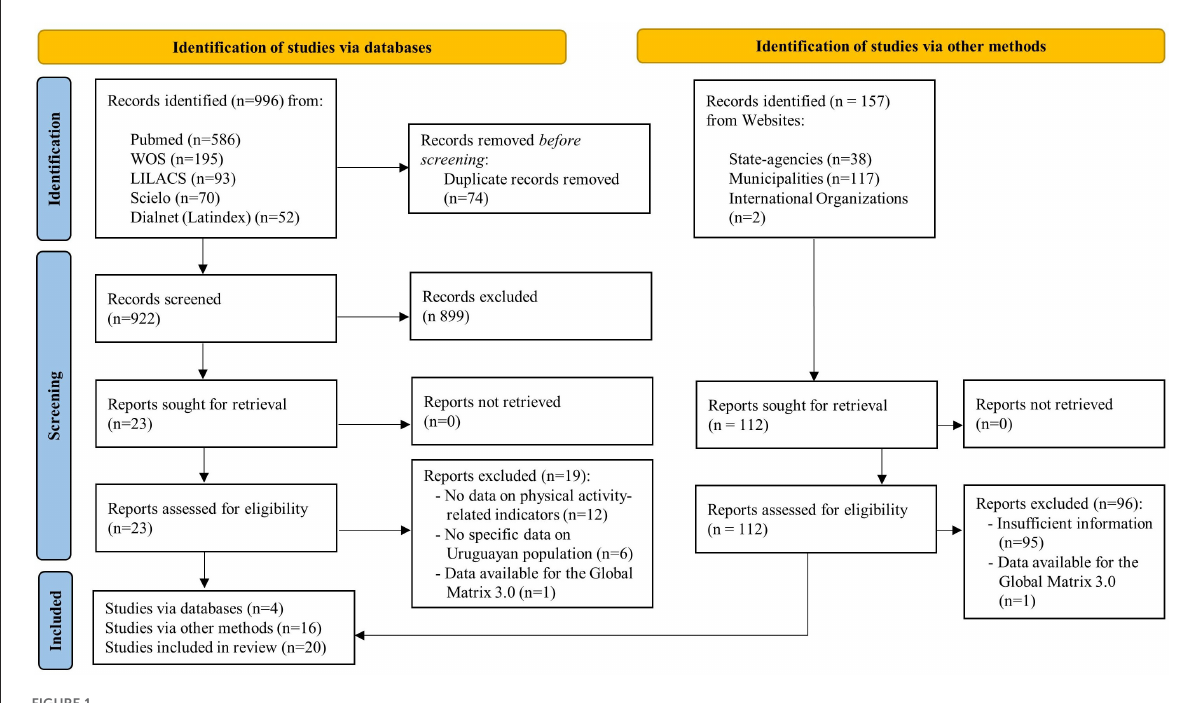
FIGURE1 PRISMA flow diagram for identifying, screening, and determining eligibility and inclusion of